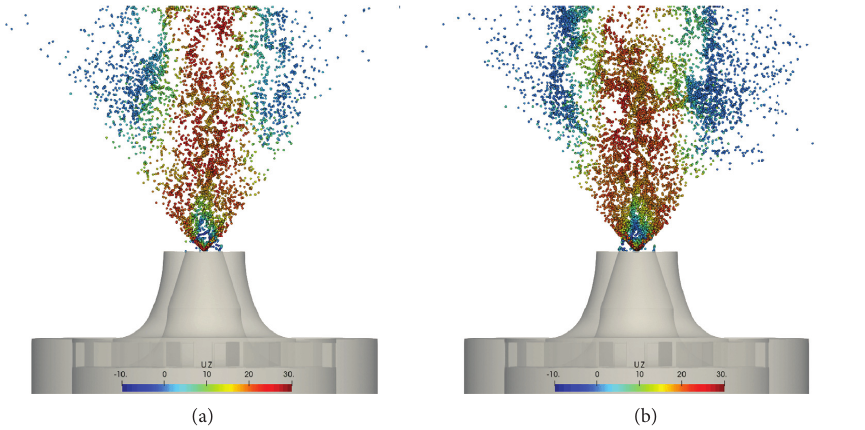
Figure 22: Droplet axial velocity for cases A-NR (a) and B-NR